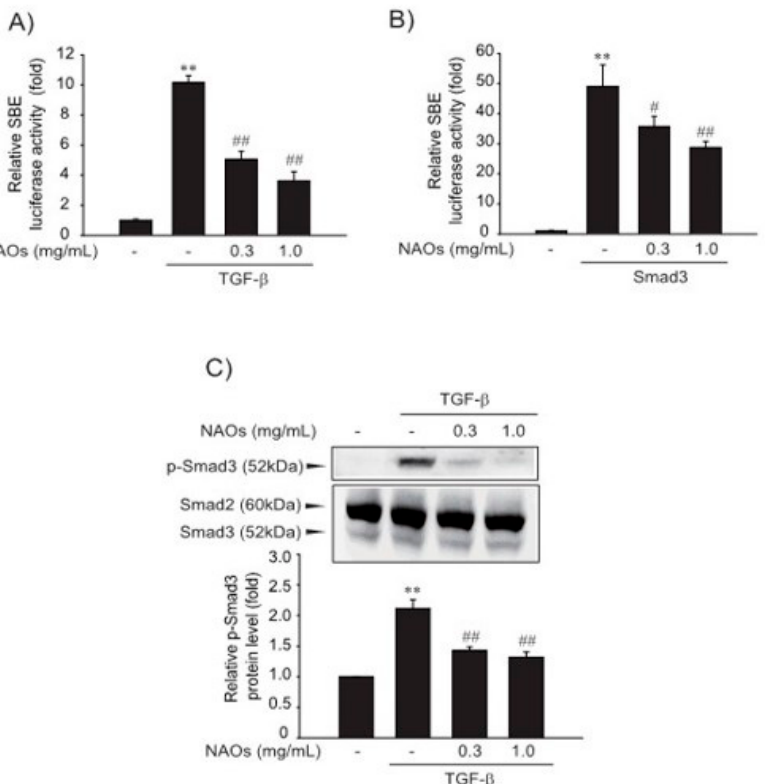
Figure 2. Inhibition of TGF- β downstream signaling by neoagarooligosaccharides (NAOs). ( A ) Effect of NAOs on TGF- β -induced Smad pathway in the LX-2 cells, determined by transfecting the cells with pGL-SBE-luciferase construct, followed by treatment with TGF- β (1 ng/mL) and/or NAOs. ( B ) LX-2 cells co-transfected with Smad3 expression construct and treated with NAOs (12 h). ( C ) Im- munoblotting for Smad3 phosphorylation. Cells treated with 0.3–1.0 mg/mL NAOs for 30 min prior to incubation with TGF- β for 30 min. Cell lysates immunoblotted for phosphorylated Smad3 and results confirmed by repeating the experiments. Data represent the mean ± S.E. of three replicates; ** p < 0.01, vs. vehicle-treated control; ## p < 0.01, # p < 0.05, vs. TGF- β alone. Minus sign (-) indicates untreated with